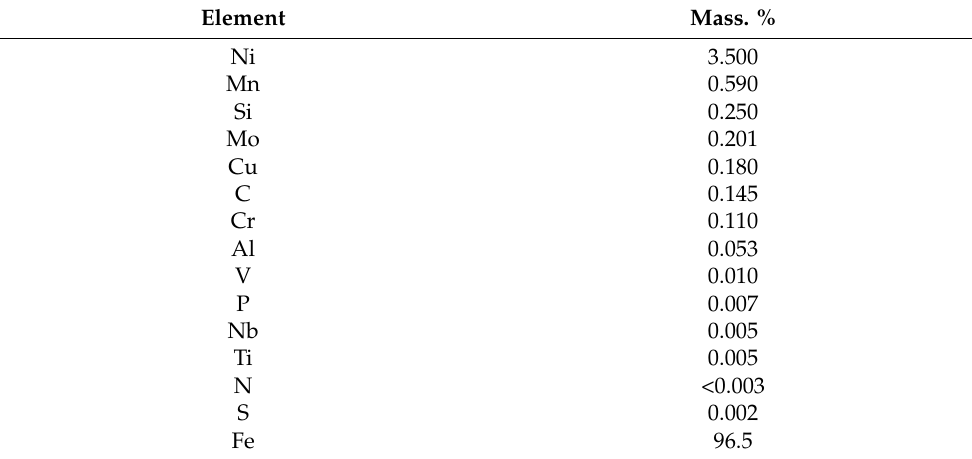
Table 2. Chemical composition of the tooth body steel.